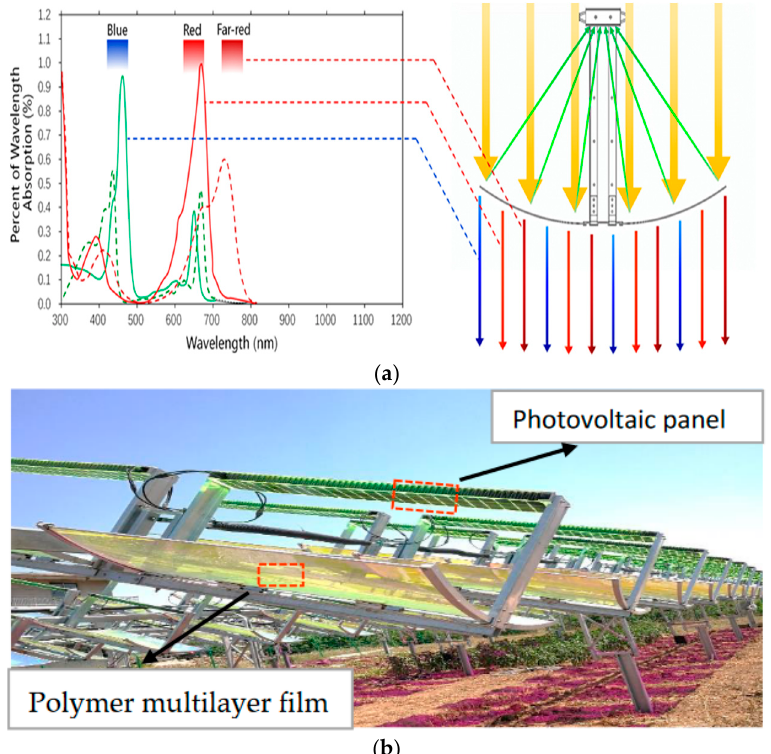
Figure 8. Polymer multilayer film applied to novel agrivoltaic system ( a ) Spectra are required for plant photosynthesis and solar power generation and ( b ) A novel agrivoltaic system applied in the agricultural field in Fu yang City, Anhui province.